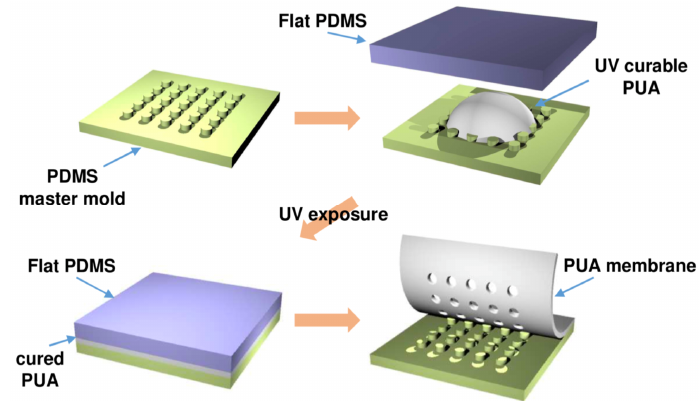
Figure 6. Illustration of the fabrication process for UV-curable polymeric membrane.